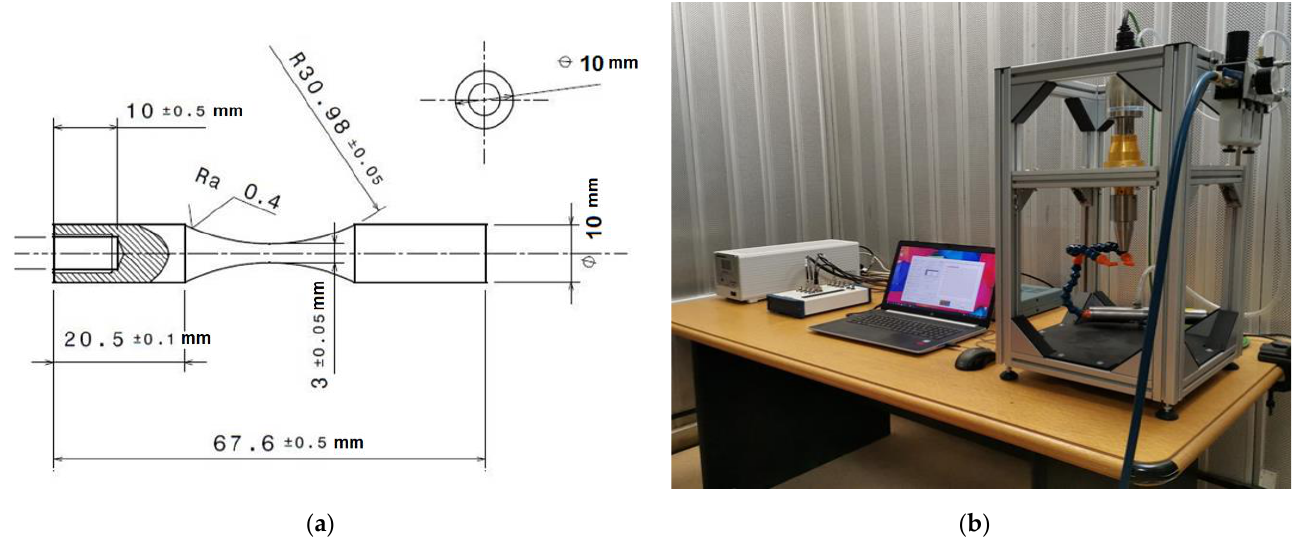
Figure 1. The scheme of VHCF specimen made from AlSi10Mg aluminum alloy ( a ) and VHCF fatigue testing system for axial loading ( b ).